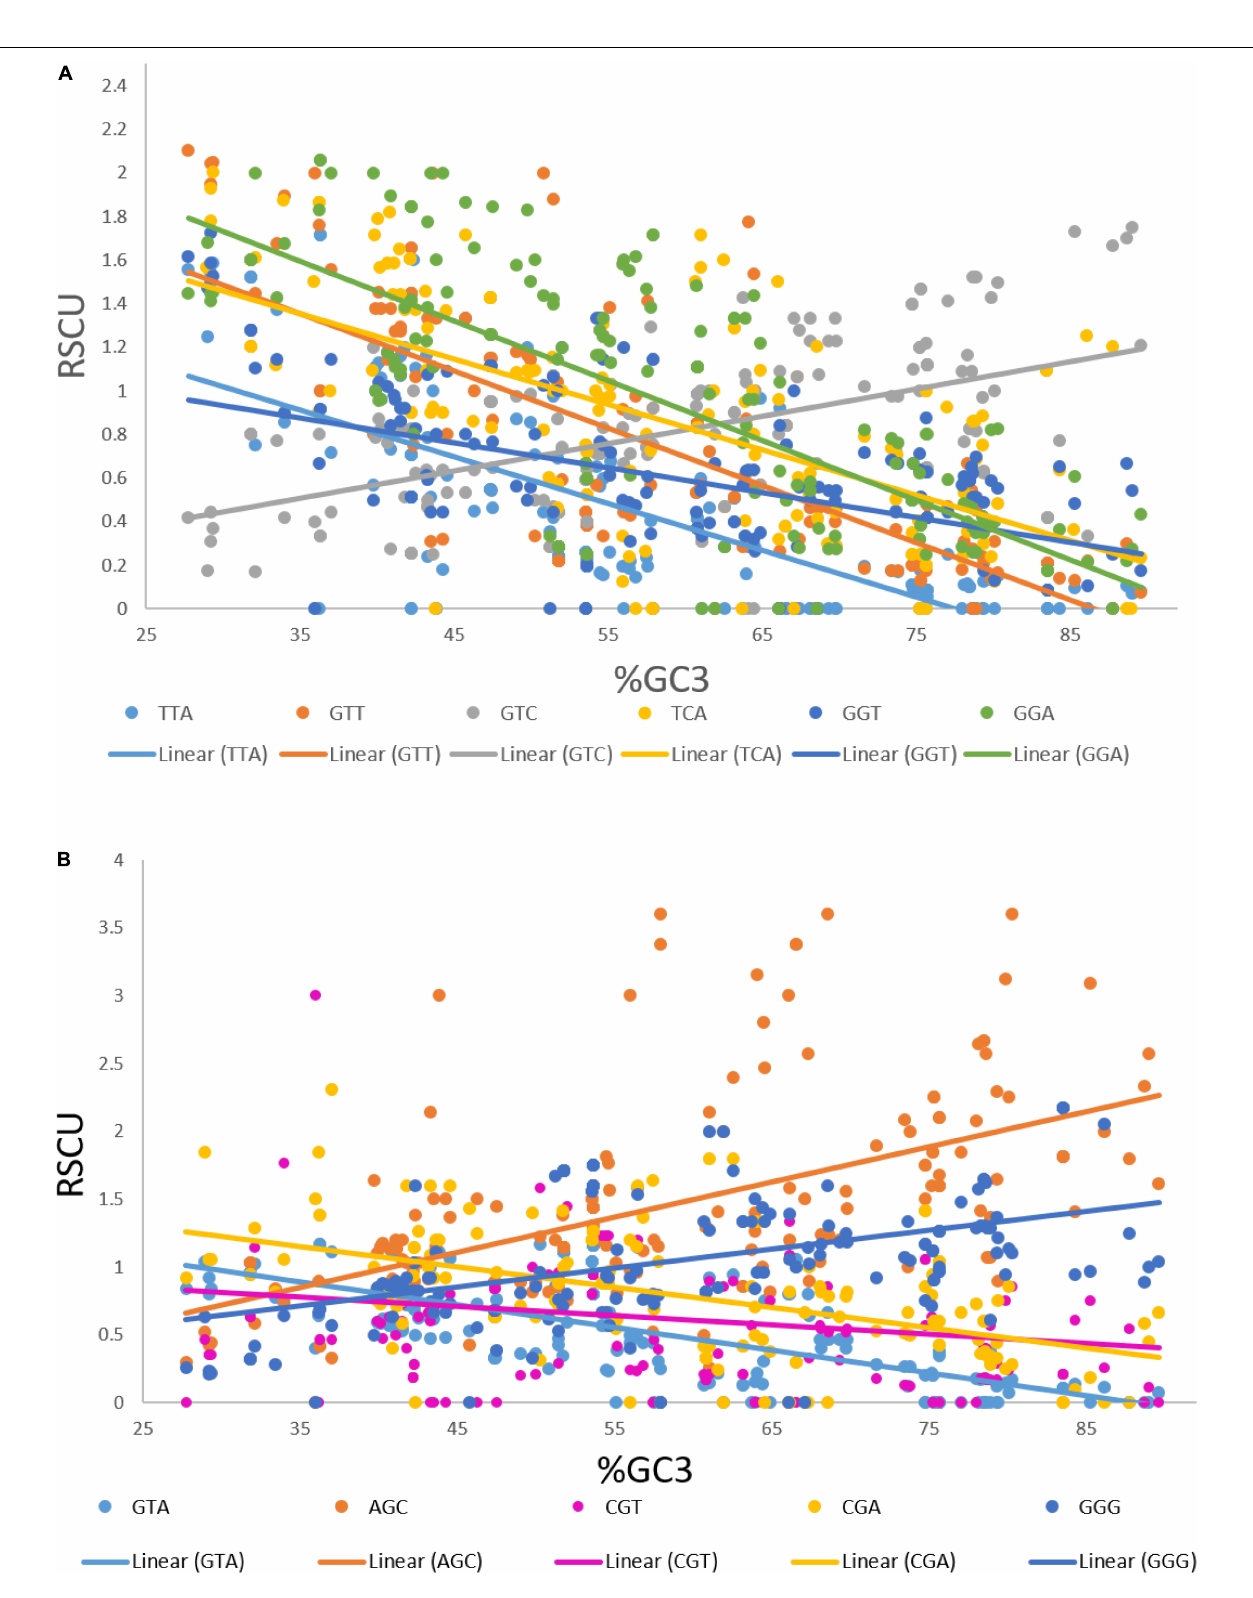
FIGURE 4 | (A) Regression plot of GC3 and RSCU values of codons that were positively associated with gene length. (B) Regression plot of GC3 and RSCU values of codons that were negatively associated with gene length.